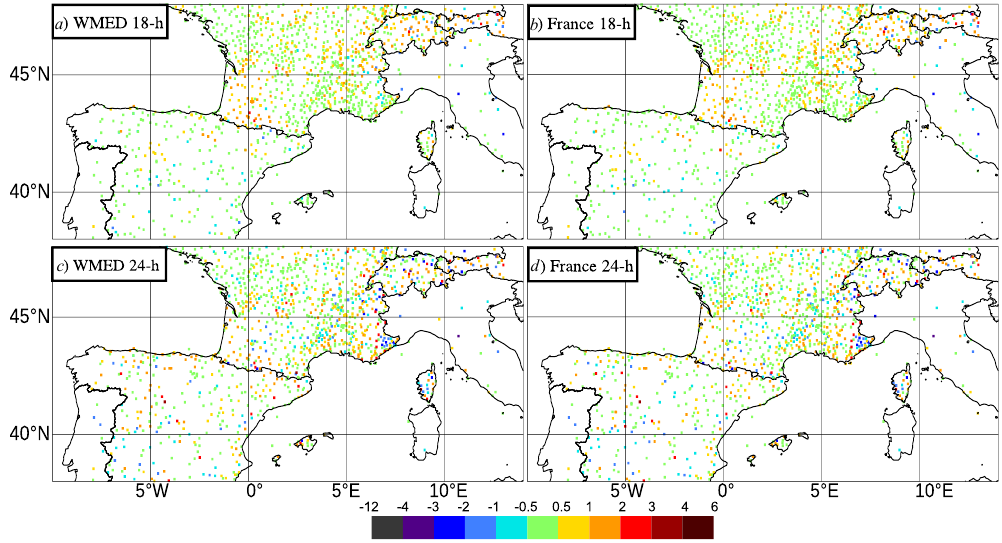
Figure 9. The 2m temperature bias (model–observation, in ◦ C) computed with surface data for the 18 and 24h forecast ranges for the SOP1 period ranging from 07 September to 05 November 2012, for AROME-WMED (left) and for AROME-France (right).